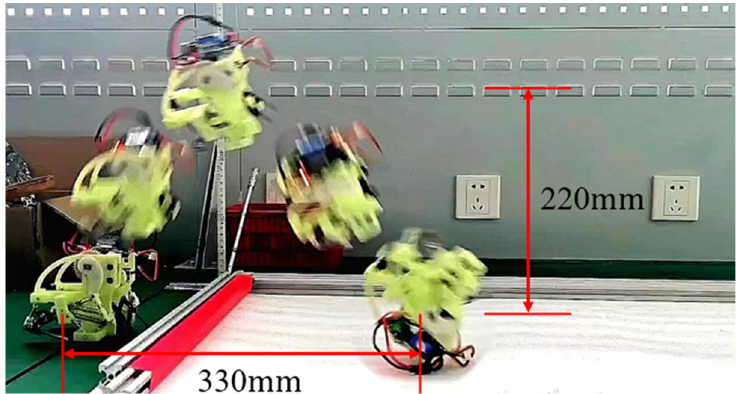
Figure 12. Robot prototype jump test.